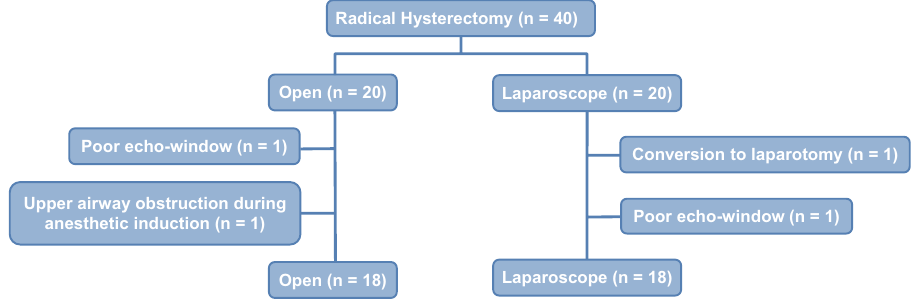
Figure 3. Flow diagram of patients who underwent radical hysterectomy. Forty patients were enrolled. Two patients were withdrawn from each group. Data from 36 patients were